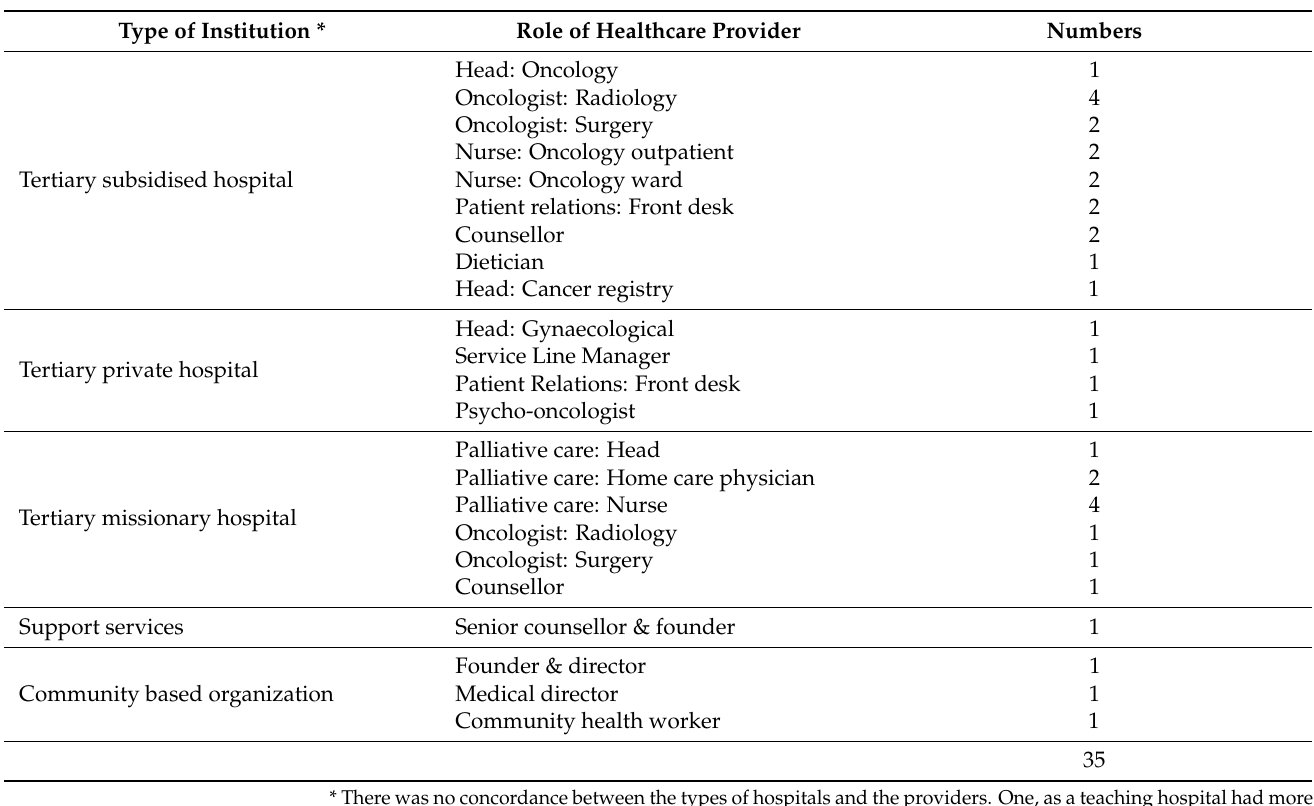
Table 1. Institutions and Roles of Healthcare